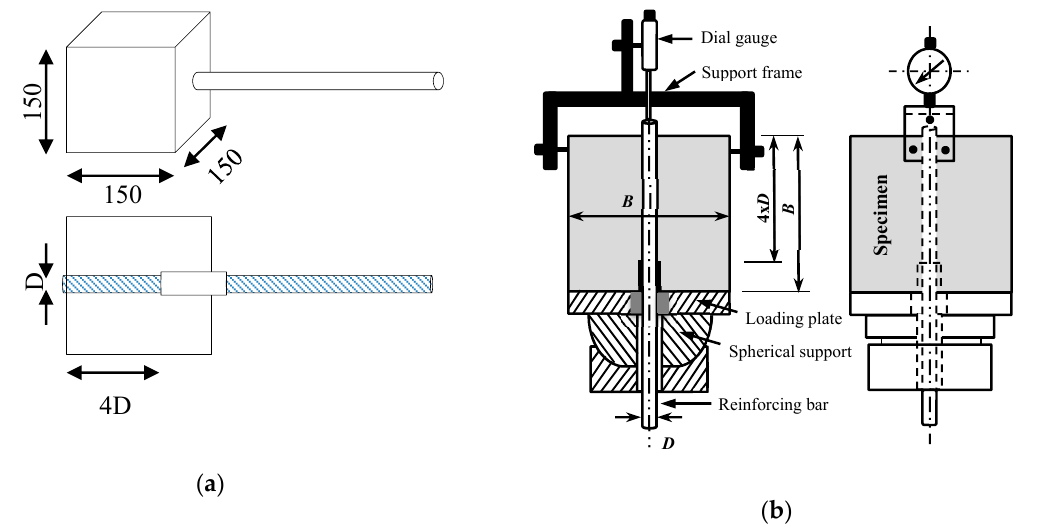
Figure 1. Specimen installation for the pull-out test using the Japan Society of Civil Engineers (JSCE) . ( a ) Dimension of specimen and ( b ) specimen installation.